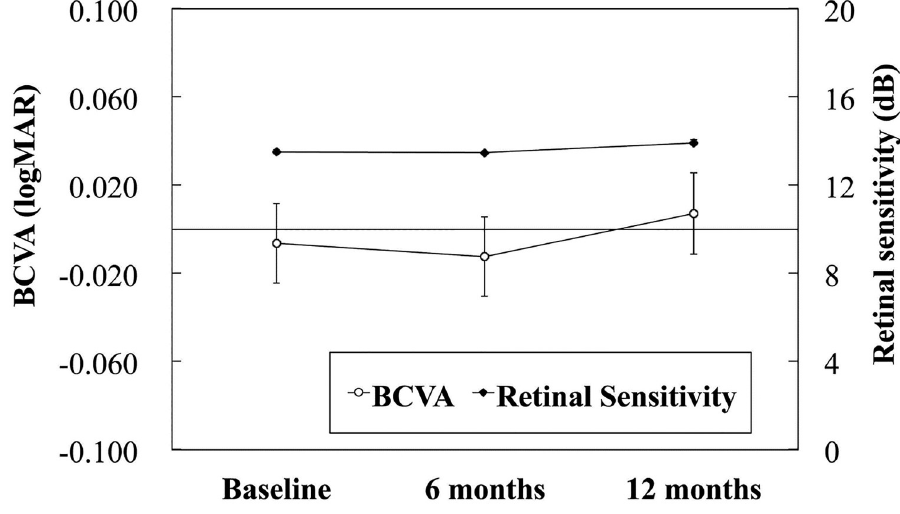
Fig 2. Changes in the mean BCVA logMAR and mean retinal sensitivity during the follow-up period. The data are expressed as the mean ± standard error of the mean. � P < 0.01 compared with baseline (paired t-test).